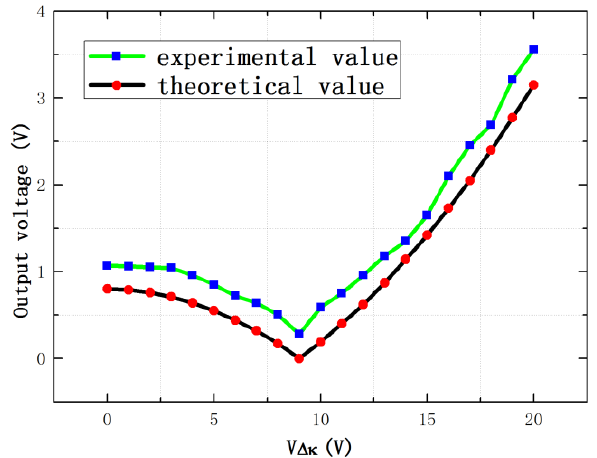
Figure 12. Comparisons with experimental and theoretical values of the vibration output.